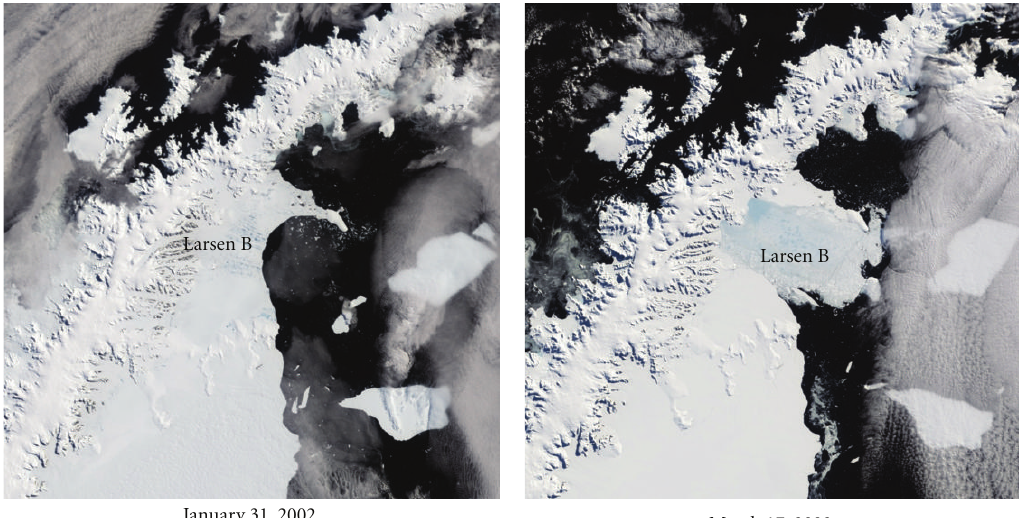
Figure 21: Moderate-resolution Imaging Spectroradiometer (MODIS) satellite imagery at the northern section of the Larsen B ice shelf on 31 January, 2002 (left), and on March 17, 2002 (right) respectively. A large floating ice mass on the eastern side of the Antarctic Peninsula has shattered and separated from the continent. The images are a courtesy of the National Snow and Ice Data Center (NSIDC), University of